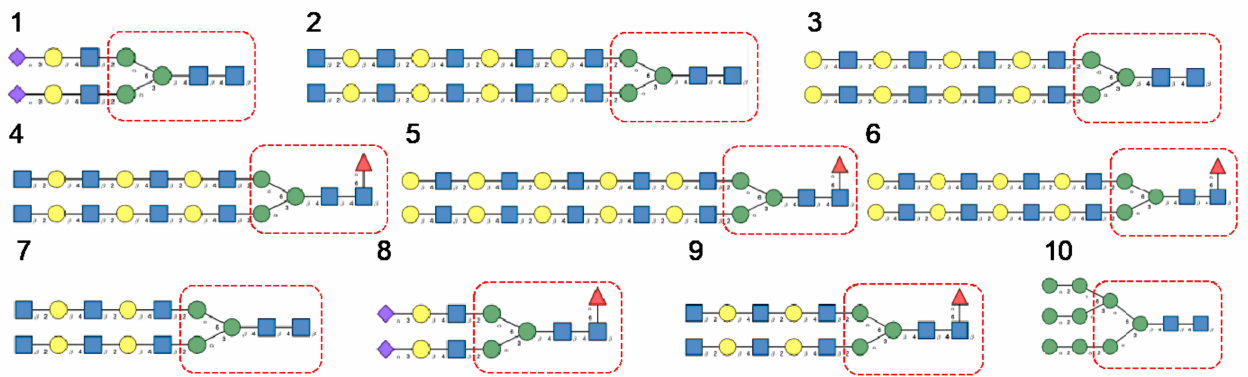
Figure 7. Glycans recognized by Con A in glycan array experiments, arranged from 1 to 10 in decreasing order of